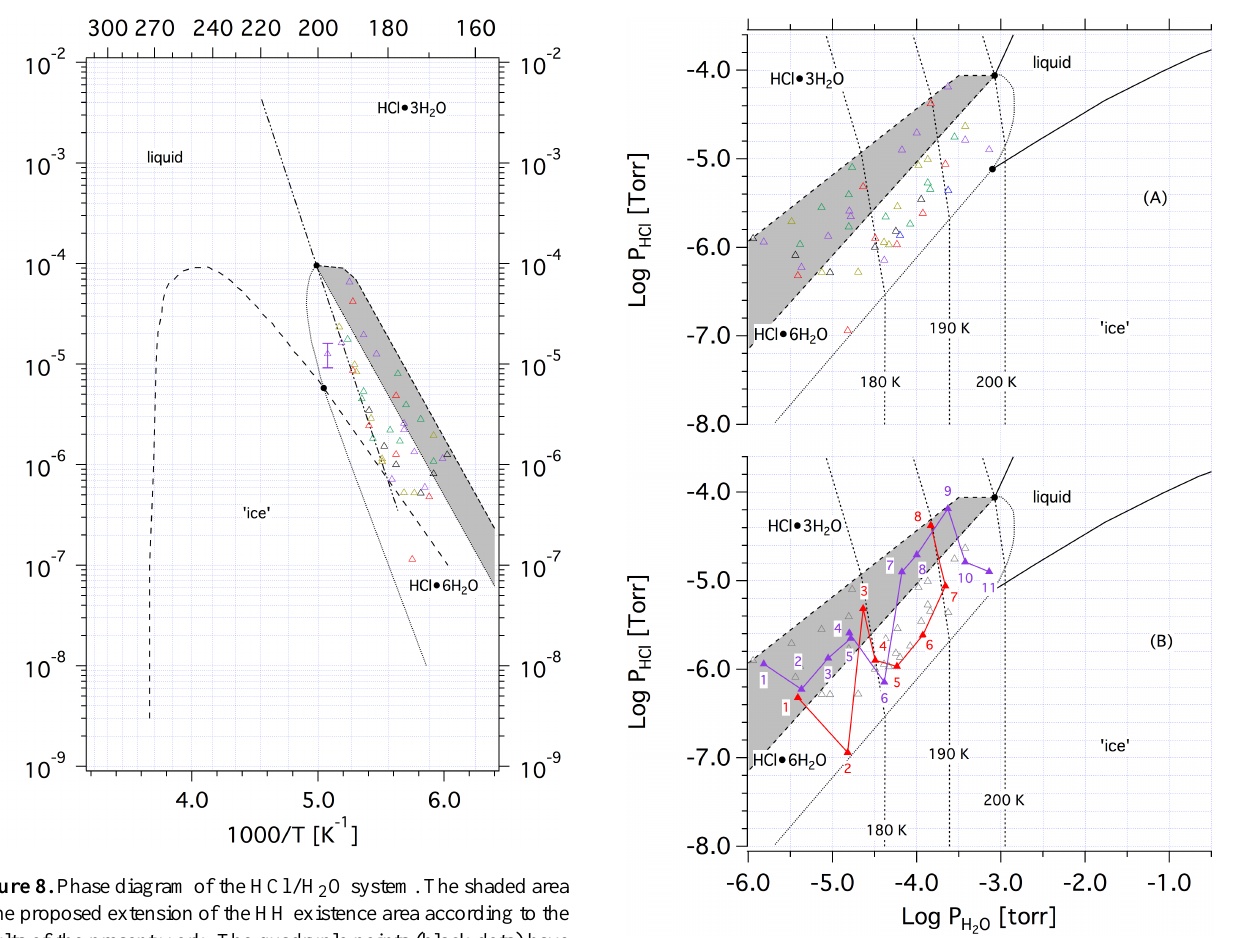
2 O system reconstructed from Hanson and 1242